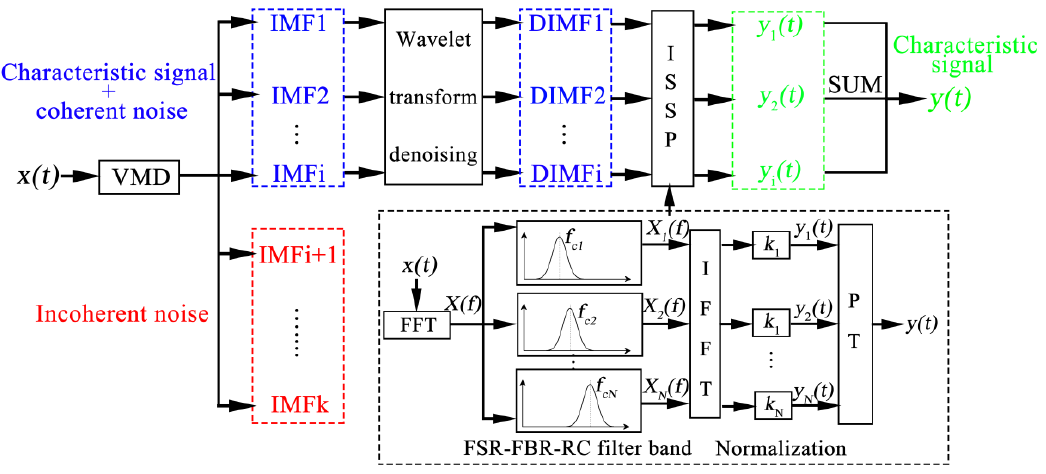
Figure 9. Schematic diagram of VWISSP.